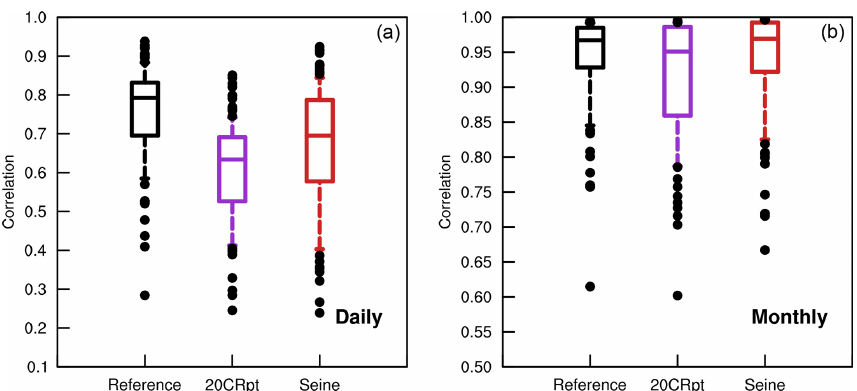
Figure 3. Spatial distribution of the correlations between the 136 river flow observations over the Seine basin at (a) daily and (b) monthly time steps and the (black) reference simulation (SAFRAN–SURFEX–Aqui-FR), (purple) the 20CRpt reconstruction described in Bonnet et al. (2017) and (red) the Seine reconstruction developed in the present study. The correlations are calculated for the period 1958–2005 and the series have been deseasonalized beforehand. The boxplots show the 10th percentile, 25th percentile, median, 75th percentile and 90th percentile. The black dots are the values below and above the 10th and the 90th percentiles, respectively.